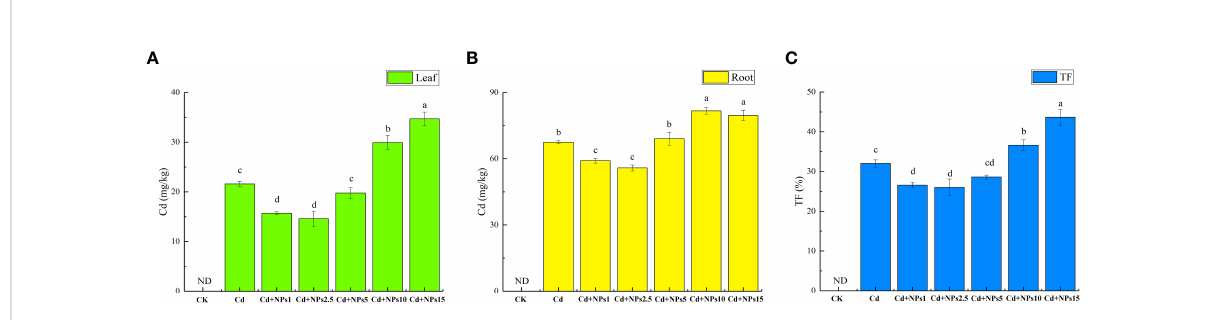
FIGURE 2 Effect of ZnONPs on Cd content in lettuce leaves (A) , Cd content in lettuce roots (B) , and Cd translocation factor (TF) under Cd stress (C) . T0, no treatment; T1, exposure to 1 mg/l Cd; T2, exposure to 1 mg/l Cd and 2.5 mg/l ZnONPs; T3, exposure to 2.5 mg/l ZnONPs. Bars marked by different letters indicate signi fi cant differences according to Duncan ’ s test ( p